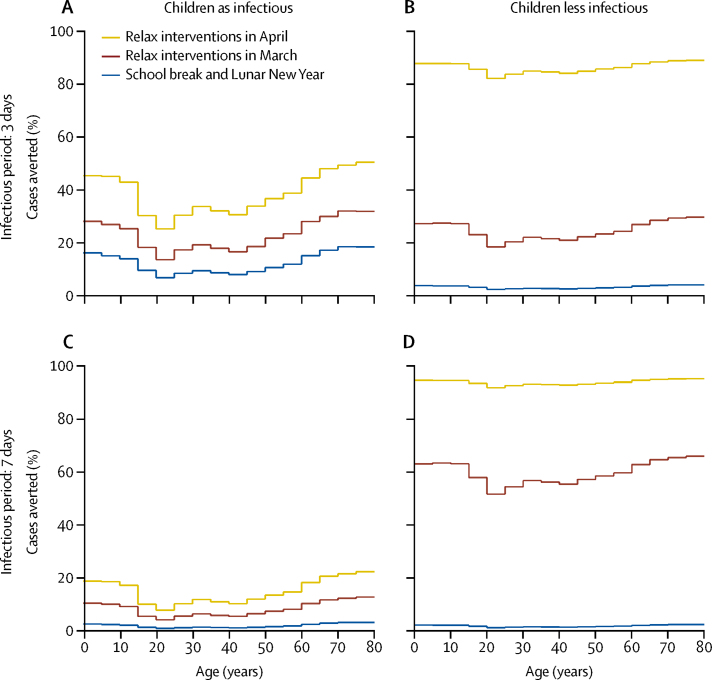
Modelled proportion of number of infections averted by end-2020 by age for different physical distancing measures, assuming the duration of infectiousness to be 3 days (A, B) or 7 days (C, D)The additional proportions of cases averted (compared with no intervention) are presented across age and by the different physical distancing measures.